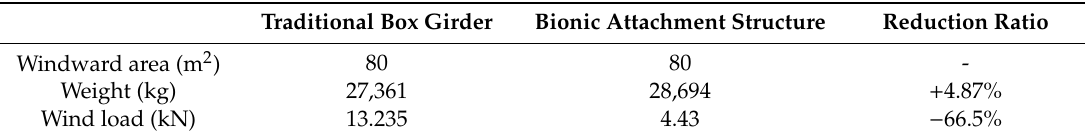
Table 5. Comparison of wind load between the two